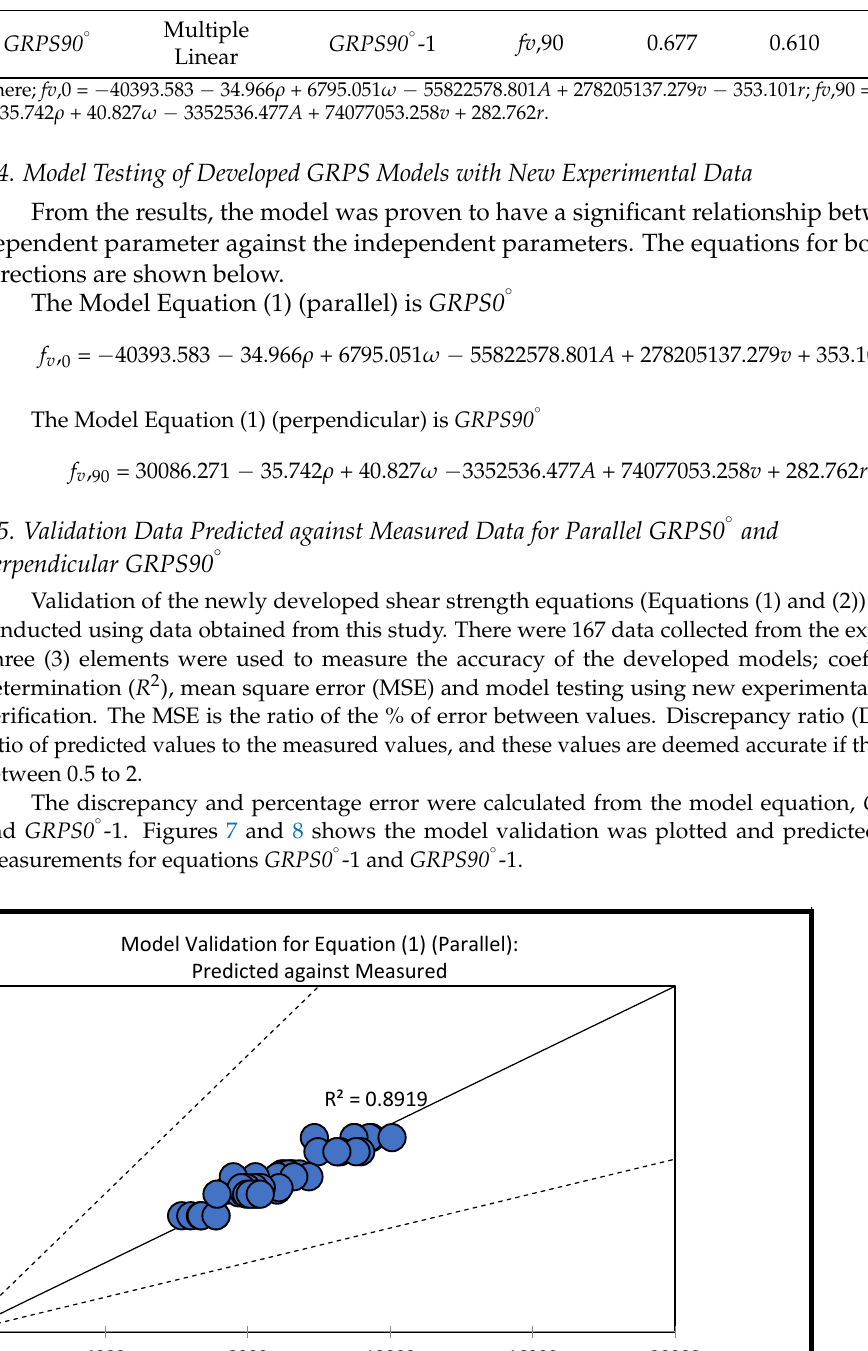
Figure 7. Model Validation for Equation (1) [ GRPS0 0 -1 ].